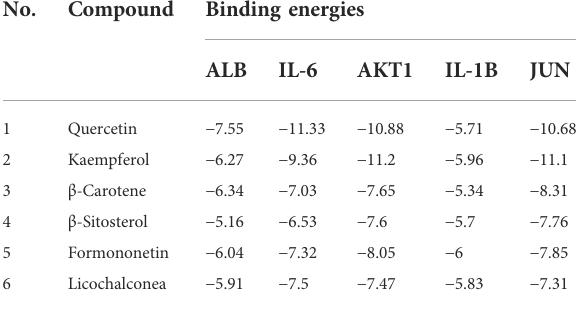
TABLE 4 Docking binding free energy of key components to core target molecules (kcalmol − 1 ).